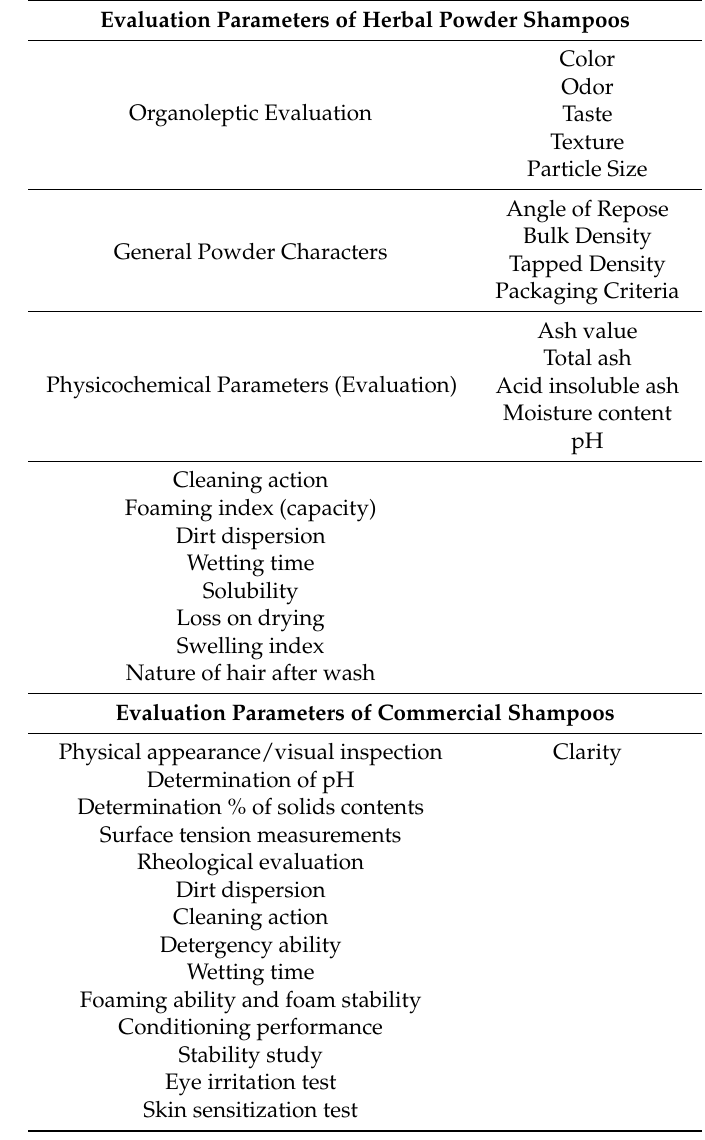
Table 1. Physicochemical properties of commercial or prepared herbal shampoo